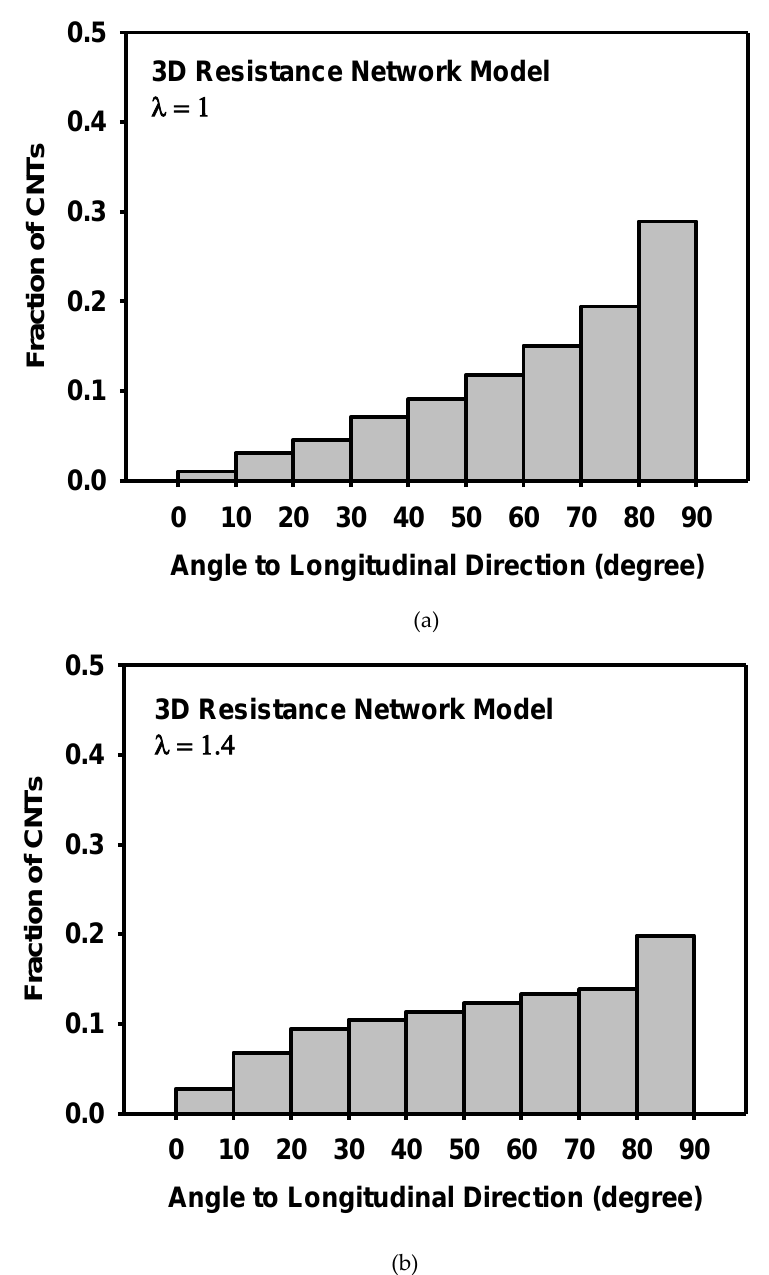
Figure 14. Distribution of the CNT angle to the longitudinal direction ( a ) at the initial state, and ( b ) at the stretch of 1.4 as calculated by the 3D resistance network model.